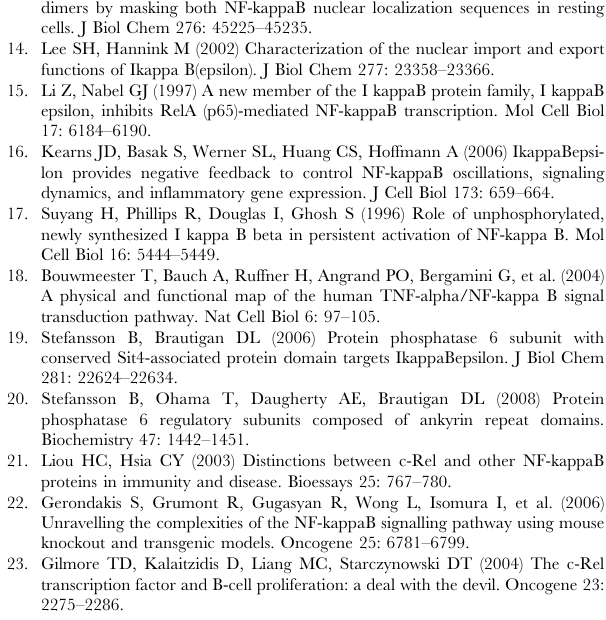
proteins, (B) jun proteins or (C) NFAT2. Protein-bound oligonu- cleotide was visualised by phosphorimaging after gel electropho- resis. Figure S4 NF- k B and I k B in input cytosol and post-